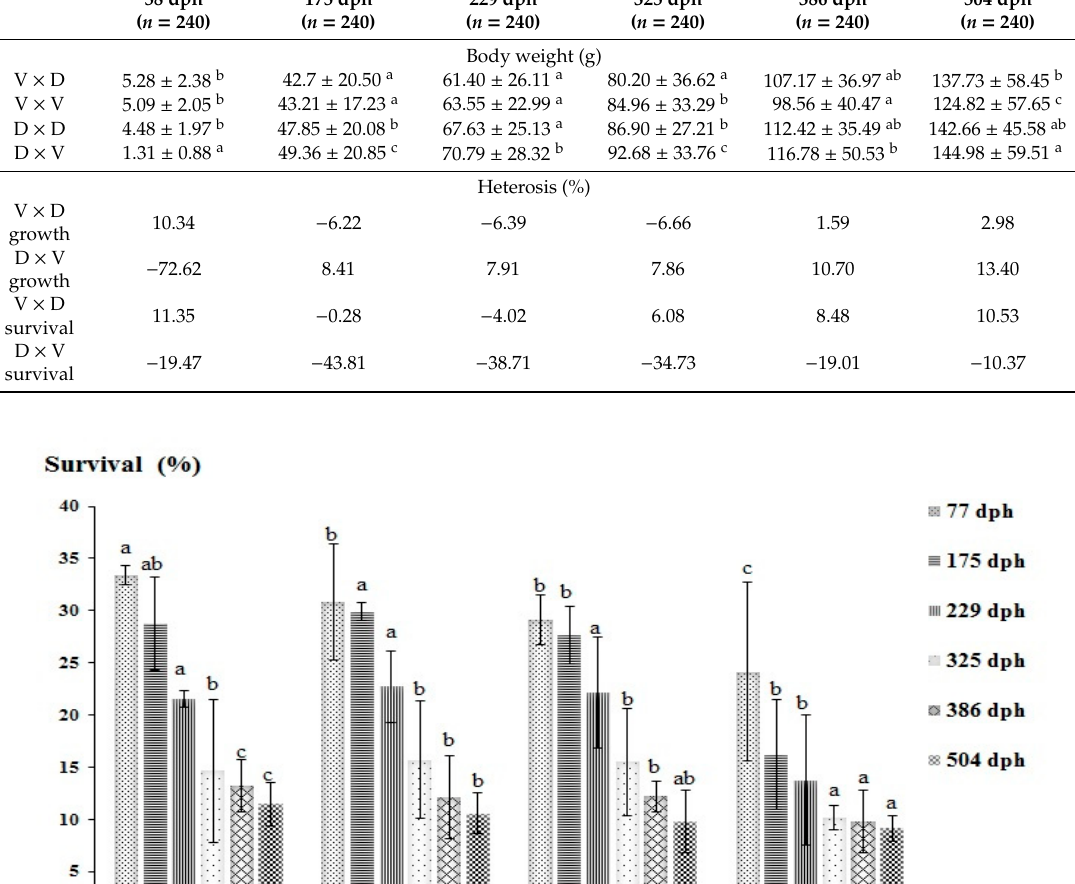
Table 4. Observed values of body weight (g mean ± SD) and average heterosis (%) of hybrid and purebred sterlet at selected days post-hatching (dph). Different superscripts within a column indicate significant differences.